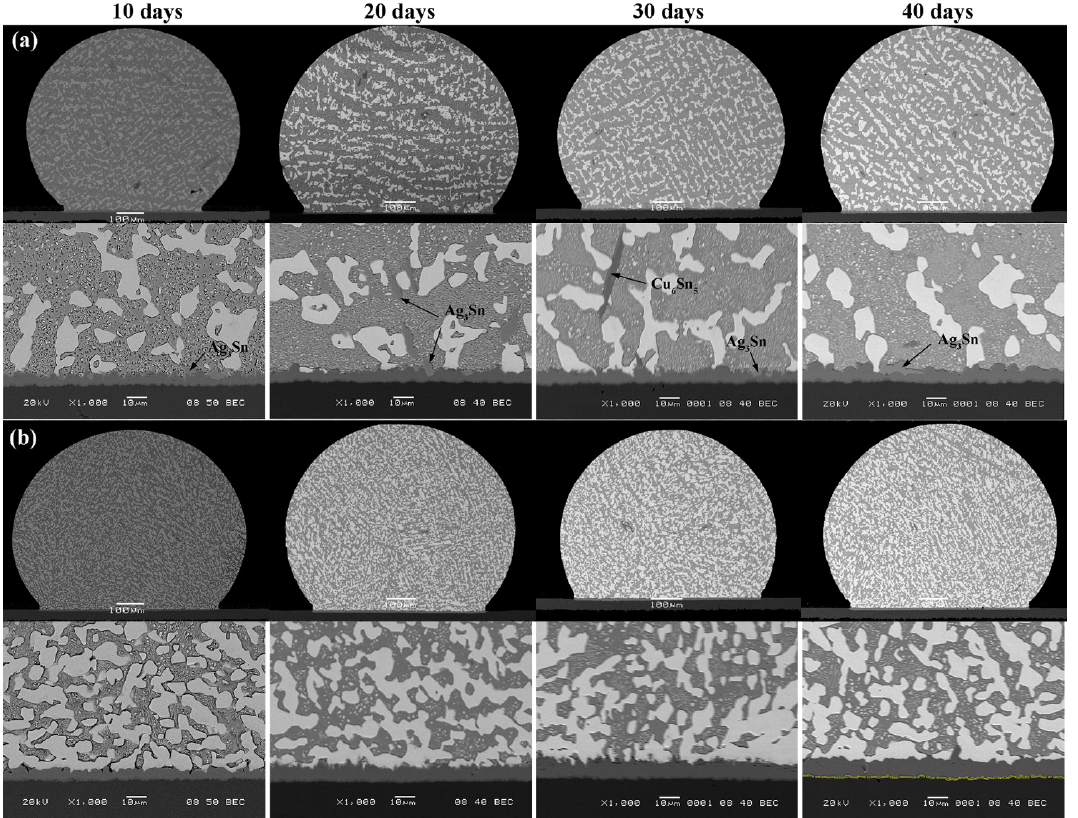
Figure 4. Microstructural evolution in solder joints during aging: ( a ) Sn ‐ 38Bi ‐ 1.5Sb ‐ 0.7Ag and ( b ) Sn ‐ 58Bi.